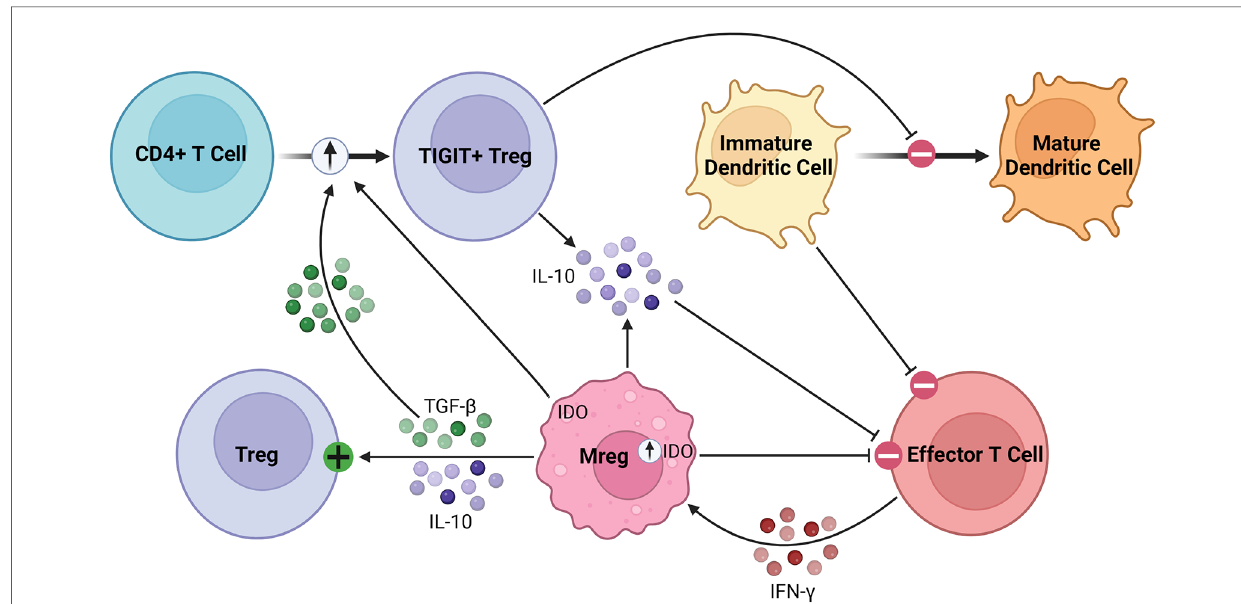
FIGURE 3 Immunosuppressive mechanisms of Mregs. Mregs express IDO in response to IFN- γ signaling, which then inhibits effector T cell proliferation. They secrete TGF- β and IL-10 to activate and promote the expansion of Tregs. Additionally, Mregs promote the conversion of allogenic CD4 + T cells to inhibitory TIGIT + Tregs through the TGF- β and IDO signaling pathways, among others. The TIGIT + Tregs secrete IL-10 and arrest dendritic cell maturation, the latter of which promotes allogenic T cell anergy or deletion through the indirect allorecognition